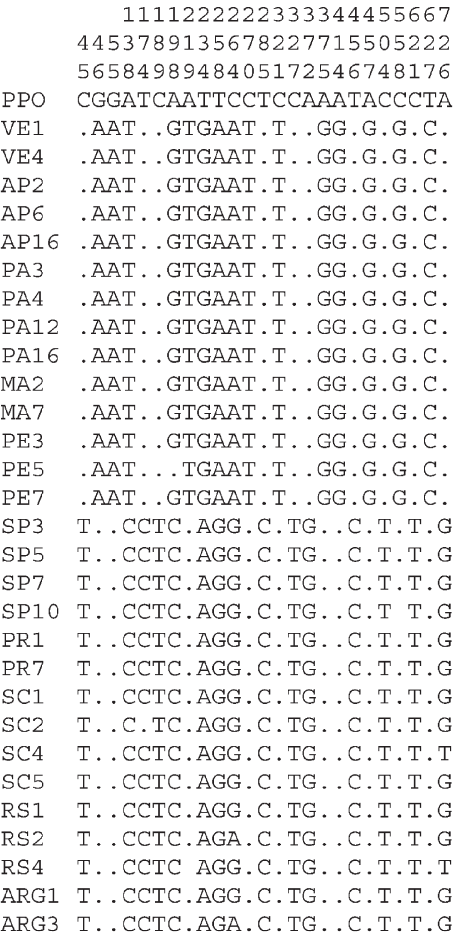
Figure2 -Cytochrome b informativesitesthatdiscriminatetropical(Ven- ezuela to Pernambuco) and subtropical (São Paulo to Argentina) Macrodon groups. The dots represent the same nucleotide as occurs in the first sequence for that site in the outgroup species Paretroplus polyactis (PPO). The codes on the left refer to the geographic location where the Macrodon ancylodon specimens were caught: VE, Venezuela; AP, Ama- pá; PA, Pará; MA, Maranhão; PE, Pernambuco; SP, São Paulo; PR, Paraná, SC; Santa Catarina; RS, Rio Grande do Sul; ARG,